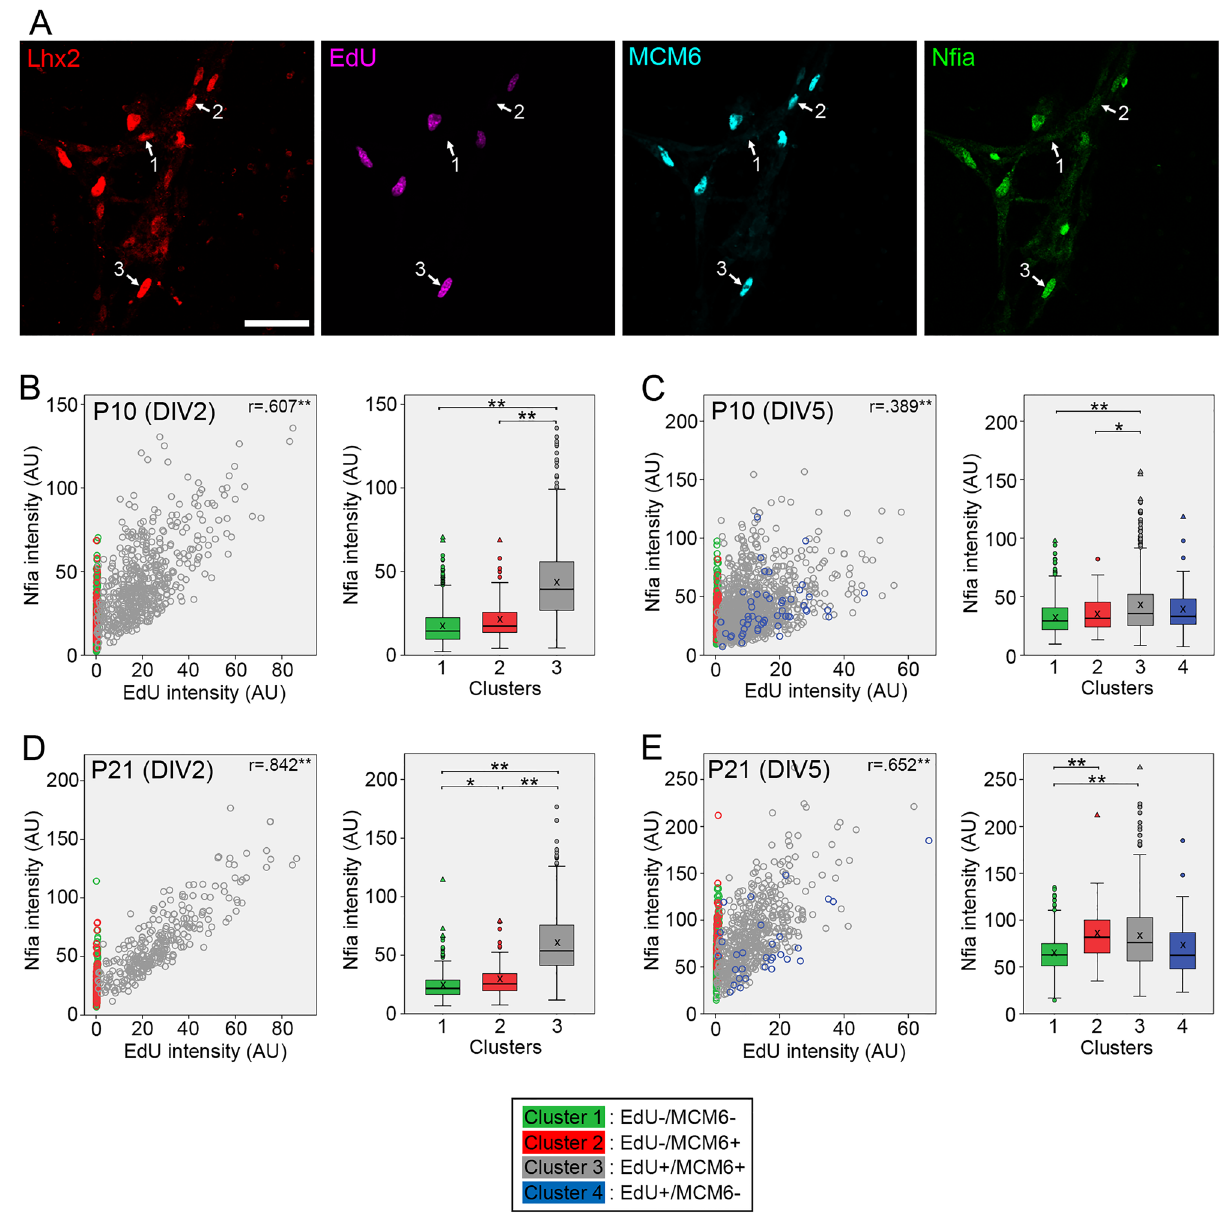
Figure 6. Quantitative analyses of Nfia expression in Müller glia dissociated from P10 and P21 mouse retinas. Intensities of EdU, MCM6 and Nfia labeling in Lhx2 + Müller glia were quantitated by image analysis and Nfia levels in Müller glia classified into four clusters are shown as scatter plots and box plots. ( A ) Confocal images of quadruple labeling for Lhx2, EdU, MCM6 and Nfia in Müller glia from P21 retina at DIV2. The numbers represent the clusters. Scale bar = 50 µm. ( B ) Plots of 1260 Müller glia from P10 retina at DIV2. ( C ) Plots of 1549 Müller glia from P10 retina at DIV5. ( D ) Plots of 671 Müller glia from P21 retina at DIV2. ( E ) Plots of 1198 Müller glia from P21 retina at DIV5. AU arbitrary units. r , Spearman’s correlation coefficients between Nfia and EdU intensities in the cluster 3. X in box plots indicates the mean. * P < 0.05, ** P <